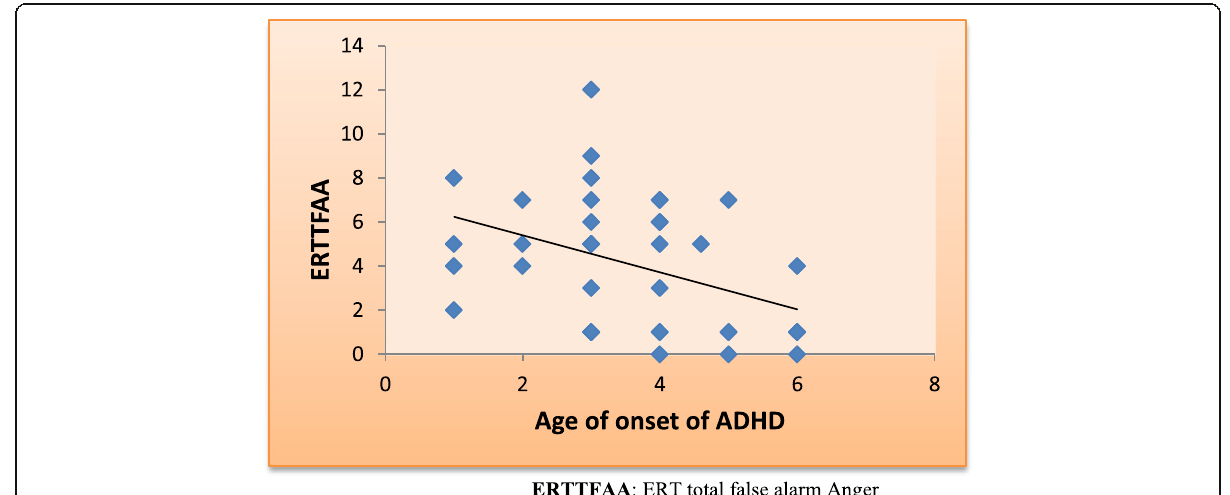
Fig. 3 Scatter chart showing negative correlation between age of onset of ADHD and ERTTFAA